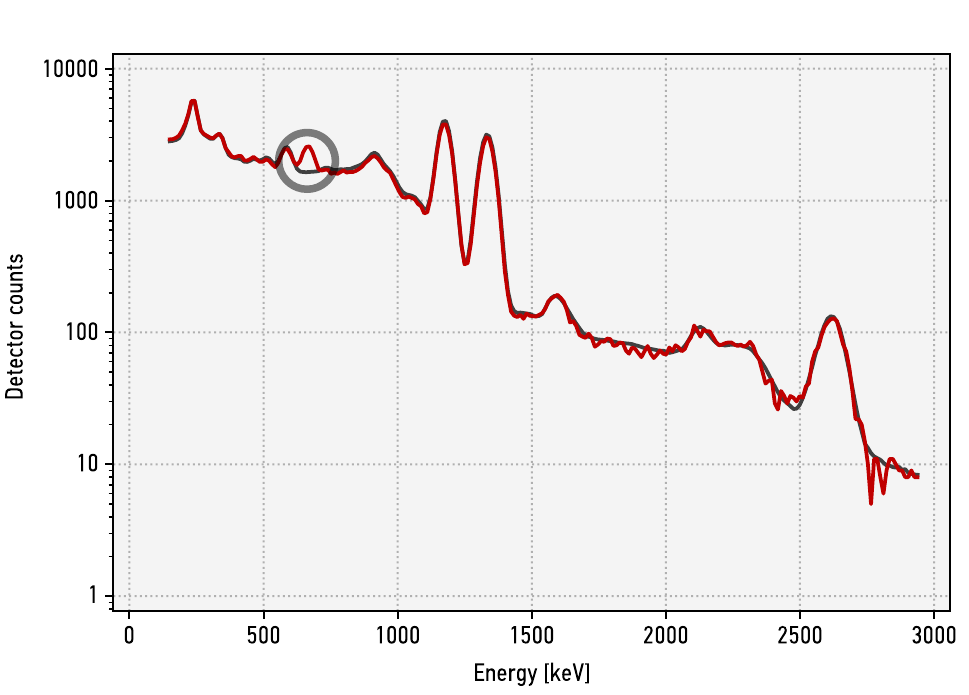
Fig 4. IBX II gamma spectra of an invalid item compared to the template. The template values are generated from the average result of 150 measurements on the reference item, represented by a cobalt-60 source. The invalid item is the same cobalt-60 source with a weak caesium- 137 contribution (661.7 keV), highlighted in the plot. Shown are the template and a single measurement with 2 18 total events.